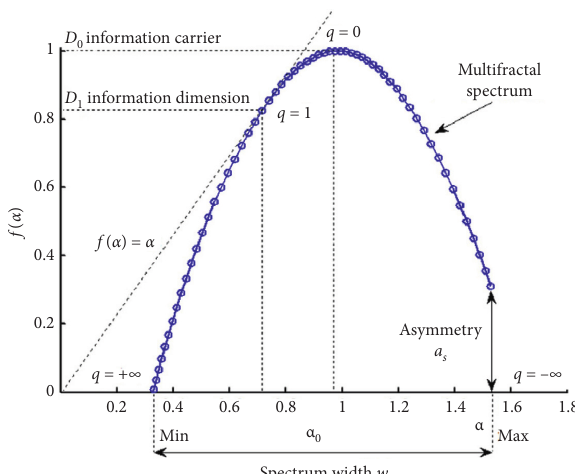
Figure 3: Schematic presentation of the main parameters (position , asymmetry a s , and width w ) of a multifractal of maximum α 0 spectrum f ( α ) . Parameters α , a s , and w are dimensionless 0 (modified figure from Baranowski et al.,